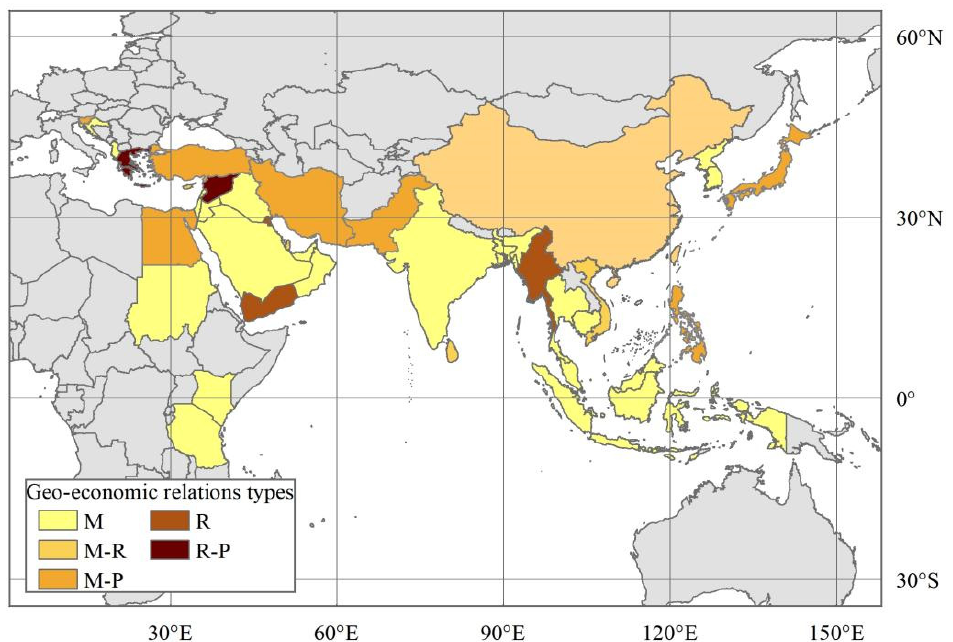
Figure 5. Types of geo-economic relations between China and the MSRCs. Note: The map is a drawing is based on the standard map of GS (2016) 1667 that comes from the standard map service system of the Ministry of Natural Resources of the People’s Republic of China (http://bzdt.ch.mnr.gov.cn/index.html, accessed on 3 October